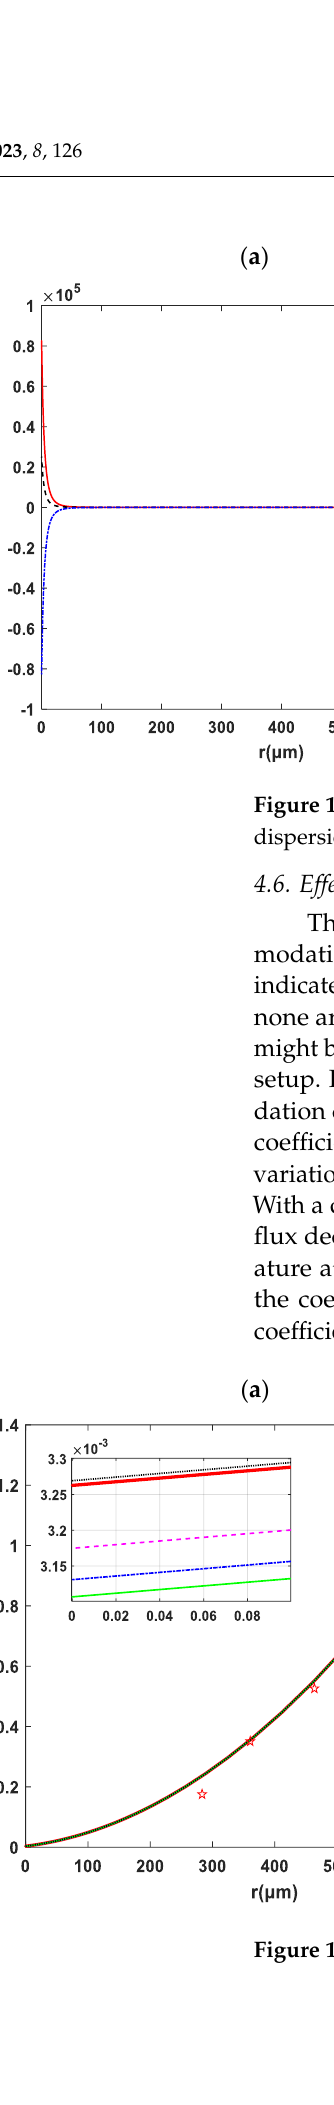
Figure 11. Radius evolutions of ( a ) film thickness; ( b ) interfacial temperature; and ( c ) evaporative mass flux for different accommodation coefficients at a time step of 3.9 ms. 4.7. Effect of Time Step All the results discussed in the previous sections are illustrated at a snapshot in time (time step 3.9 ms). However, experimental data was obtained at 1 ms intervals and com- parisons can be made at each time step. This section expands the previous discussion for multiple time steps. The numerical model was run for different time steps at 0.9, 1.9, 2.9, and 3.9 ms with variable wall temperature, applied slip velocity, and an accommodation coefficient of 0.01. Initially, the variations of the wall temperature for different time steps are depicted and compared with the experimental results, which can be seen in Figure 3b. Wall temperature from the experimental data shows that initially, the wall temperature is highest in the thick region of the film. However, as time progresses, the wall temperature peak shifts to the thinner region of the film. When this is accounted for, the thin film profile from the model is in good agreement with the experimental results for all time steps. Changes in the film thickness, mass flow rate, interfacial temperature, and evaporative mass flux, are depicted in Figure 12a–d, respectively. As can be seen in Figure 12a, the radius of the bubble clearly increased at each region of the film by increasing the time step. Additionally, Figure 12b shows that, at a particular point of the bubble radius, a higher mass flow rate is observed for smaller time steps in the thicker region and obtained